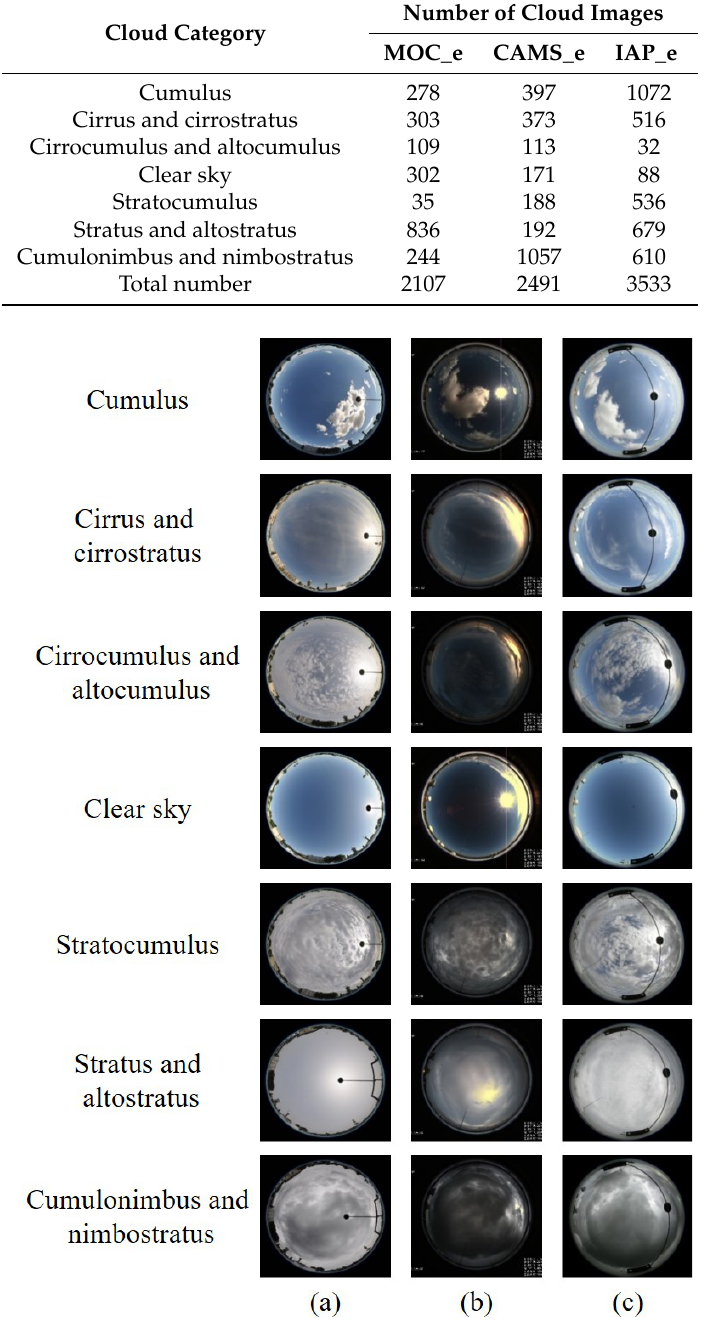
Figure 5. We present cloud samples of each category (each row indicates one category) from the three cloud datasets, i.e., ( a ) the MOC_e, ( b ) the CAMS_e, and ( c ) the